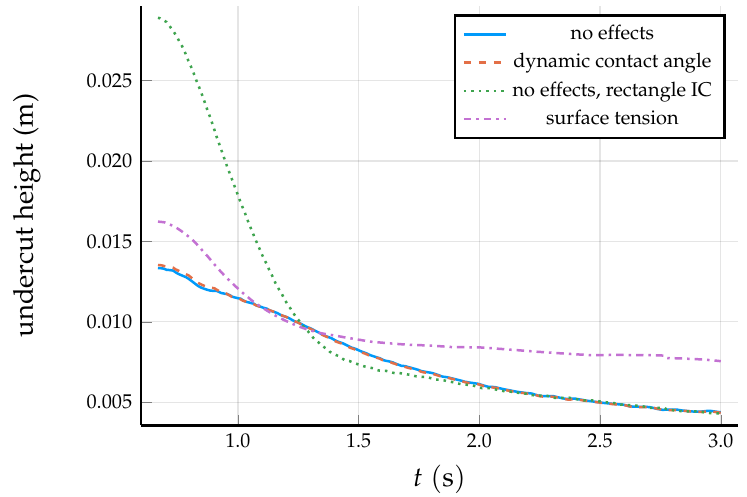
Figure 4. Height of undercutting plotted from its maximum as a function of time. The removal of surface tension results in a profile with less